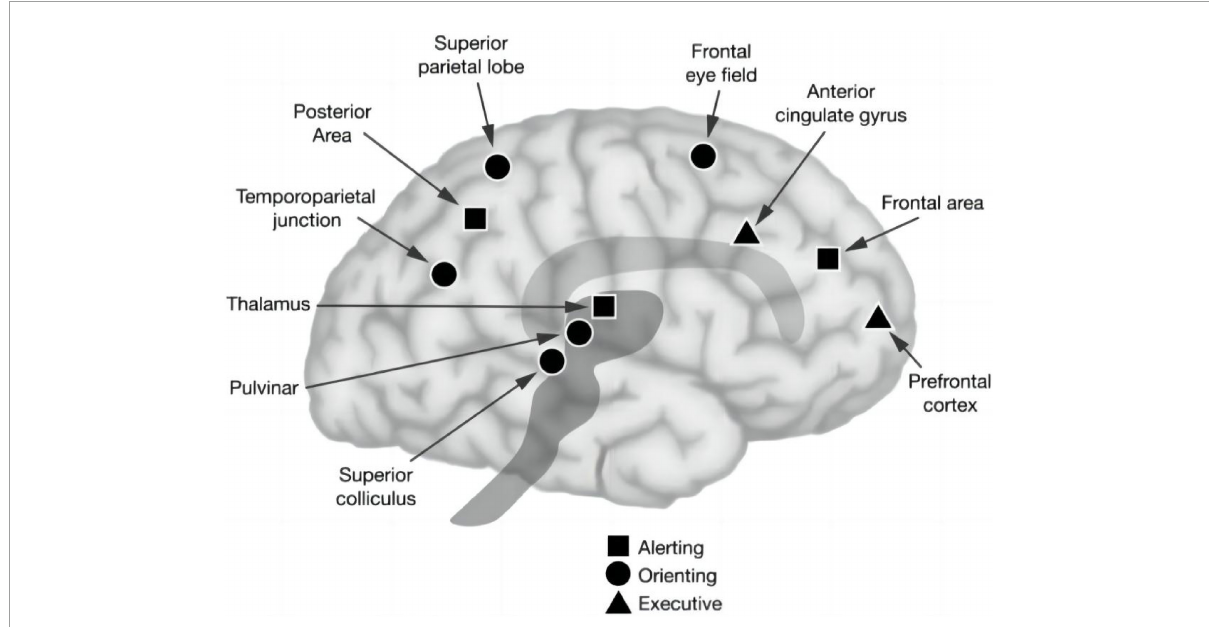
FIGURE1 Anatomy of three attentional networks: alerting, orienting, and executive control attention (Posner and Rothbart,